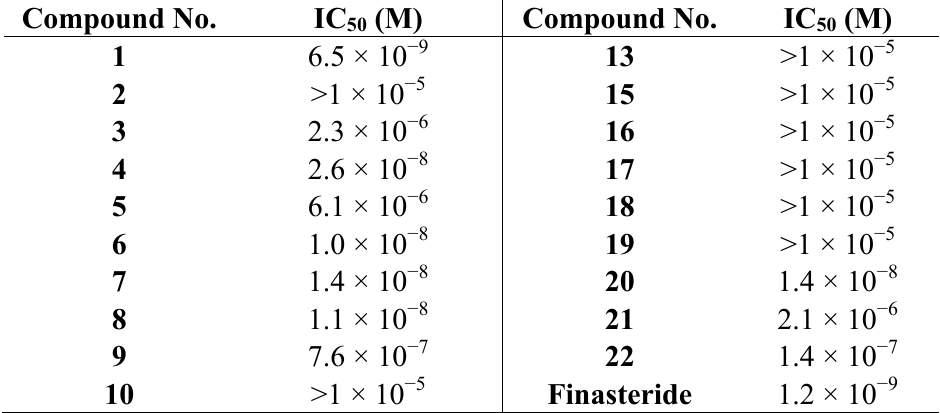
Table 1. Screening results of testosterone 5 α -reductase inhibitory activity. Compound